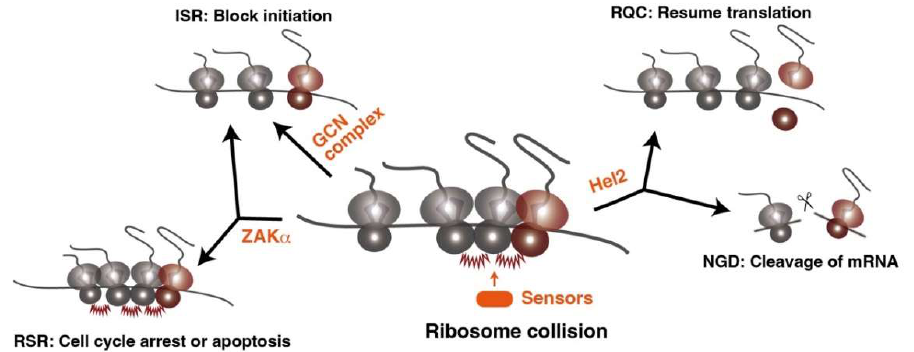
Figure 1. The response to the ribosome collision. Several sensor proteins detect the ribosome collision and induce different pathways. Hel2 (Znf598 in mammals) induces ribosome-associated quality control (RQC) and the no-go decay (NGD). The general control nonderepressible (GCN) complex induces an integrated stress response (ISR). ZAKα induces cell cycle arrest or apoptosis via the p38 or c-Jun pathway, respectively, which are called ribotoxic stress response (RSR).